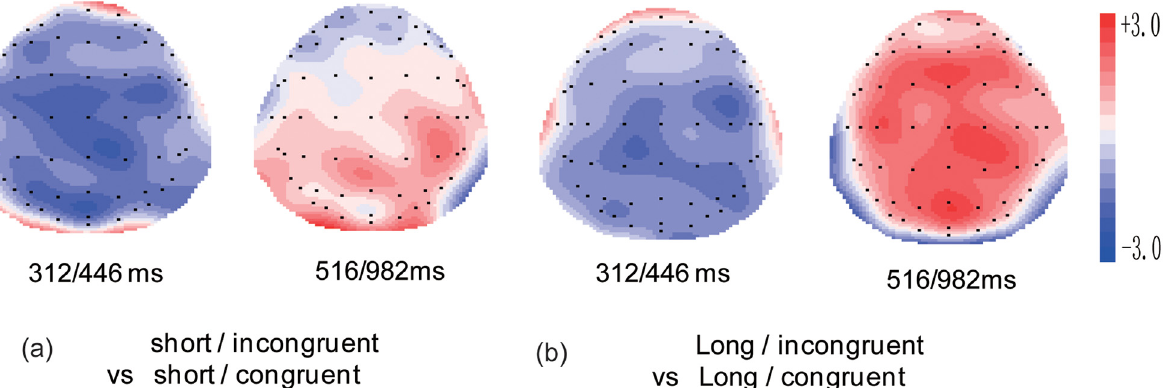
Fig 3. Topographies of the difference wave formed by subtracting ERPs to the short/ congruent from short /incongruent (a), and ERPs to the long/ congruent from long /incongruent (b) in selected time